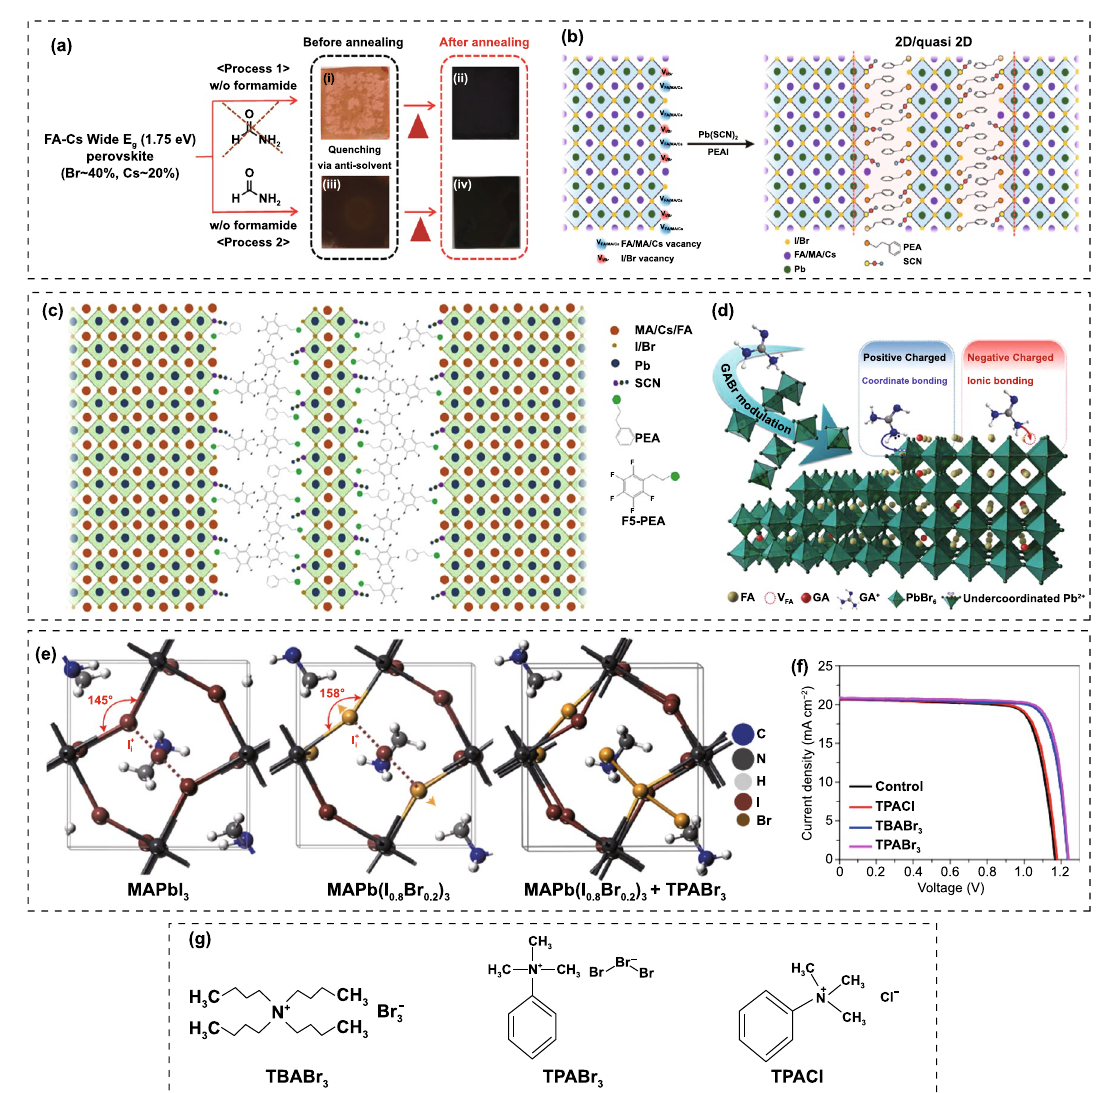
Fig. 8 a FA-Cs WBG perovskite formation process without and with formamide additive. Reproduced with permission from Ref. [136]. Copy- right 2018, Wiley–VCH. b Schematic illustration of defect passivation at perovskite grain boundaries (or surfaces) by PEA + and SCN − . Repro- duced with permission from Ref. [140]. Copyright 2019, Elsevier. c Illustration of perovskite structure based on mixed-cation 2D-PPA. Repro- duced with permission from Ref. [144]. Copyright 2020, Wiley–VCH. d Schematic mechanism of GABr modulation on FAPbBr 3 based PSCs. Reproduced with permission from Ref. [146]. Copyright 2022, Elsevier. e Geometrical structures of MAPbI 3 and MAPb(I 0.8 Br 0.2 ) 3 with iodide interstitials, and the calculated geometrical structure of MAPb(I 0.8 Br 0.2 ) 3 with Br 3– . f J-V curves of Cs 0.1 FA 0.2 MA 0.7 Pb(I 0.85 Br 0.15 ) 3 solar cells with additives of TPABr 3 , TBABr 3 or TPACl, respectively. g Molecular structures of TBABr 3 , TPABr 3 and TPACl. Reproduced with permission from Ref. [147]. Copyright 2022, Nature Publishing